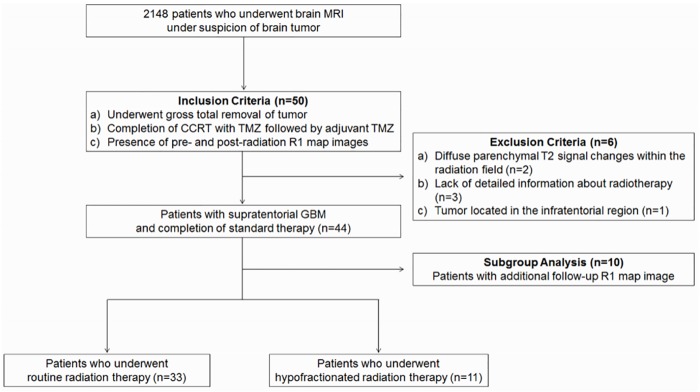
Flow chart of the study population.Note: MRI = magnetic resonance imaging, CCRT = concurrent chemoradiotherapy, TMZ = temozolomide, GBM = glioblastoma multiforme.